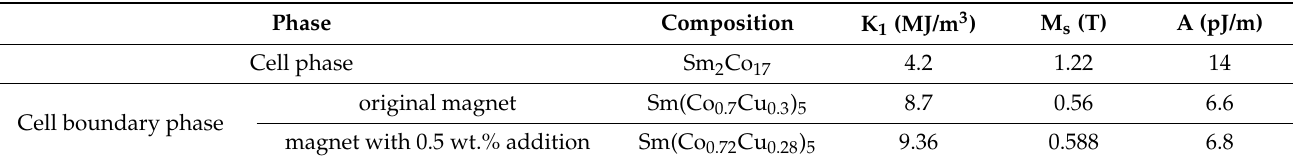
Table 2. Composition corresponding to the cell phase and cell boundary phase in the original magnet